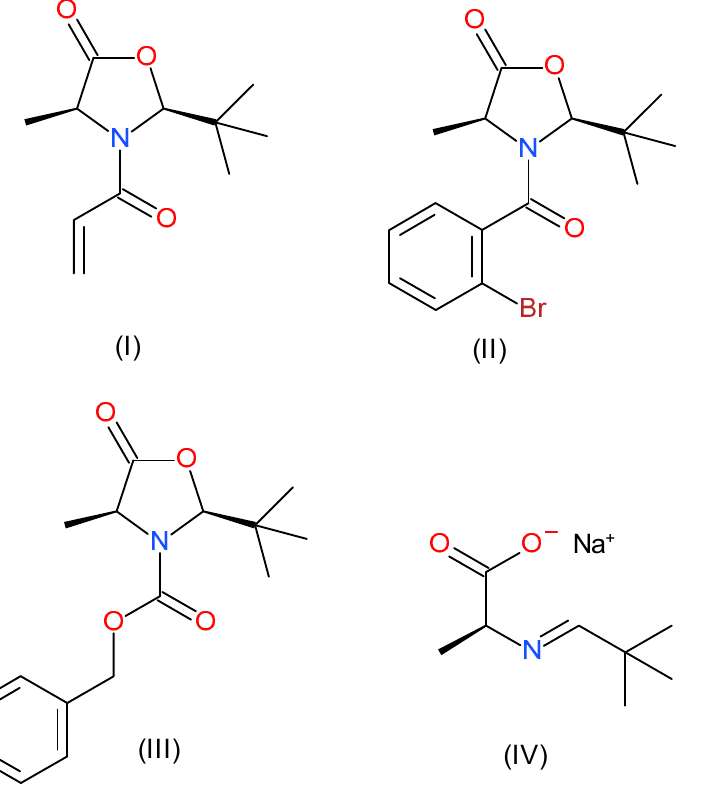
Scheme 1. the syntheses and single crystal structures of three new chiral oxazolidin-5-ones and